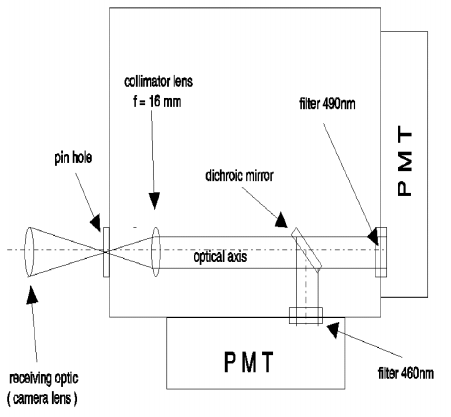
Figure 46. Modified system for simultaneous measurements of the intensity ratio and lifetime decay response modes